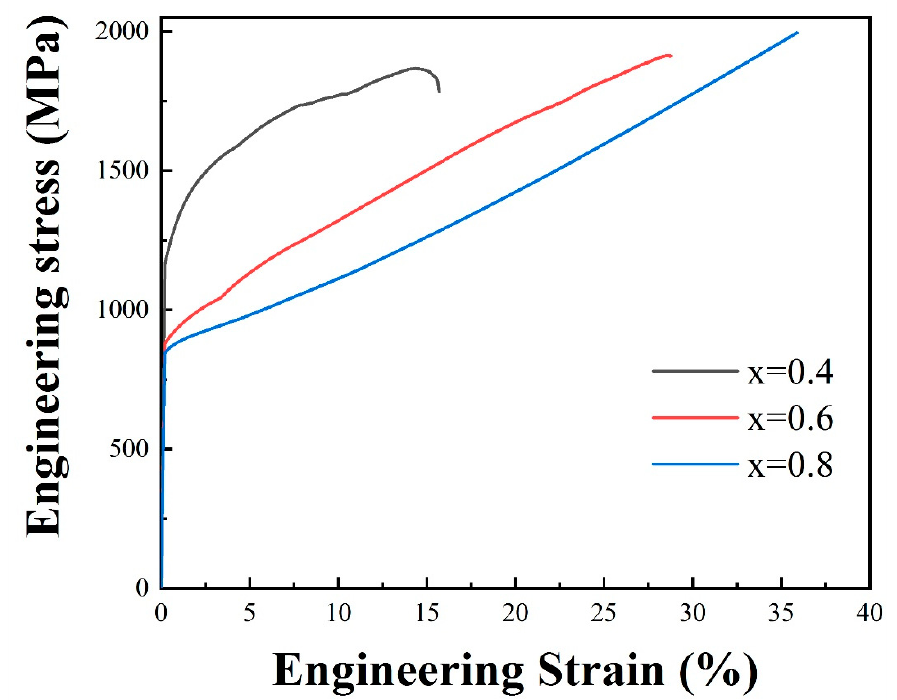
Figure 4. Compressive engineering stress–strain curves for (TiZr) x (NbTaV) 1 − x ( x = 0.4, 0.6, and 0.8) RHEAs at room temperature.